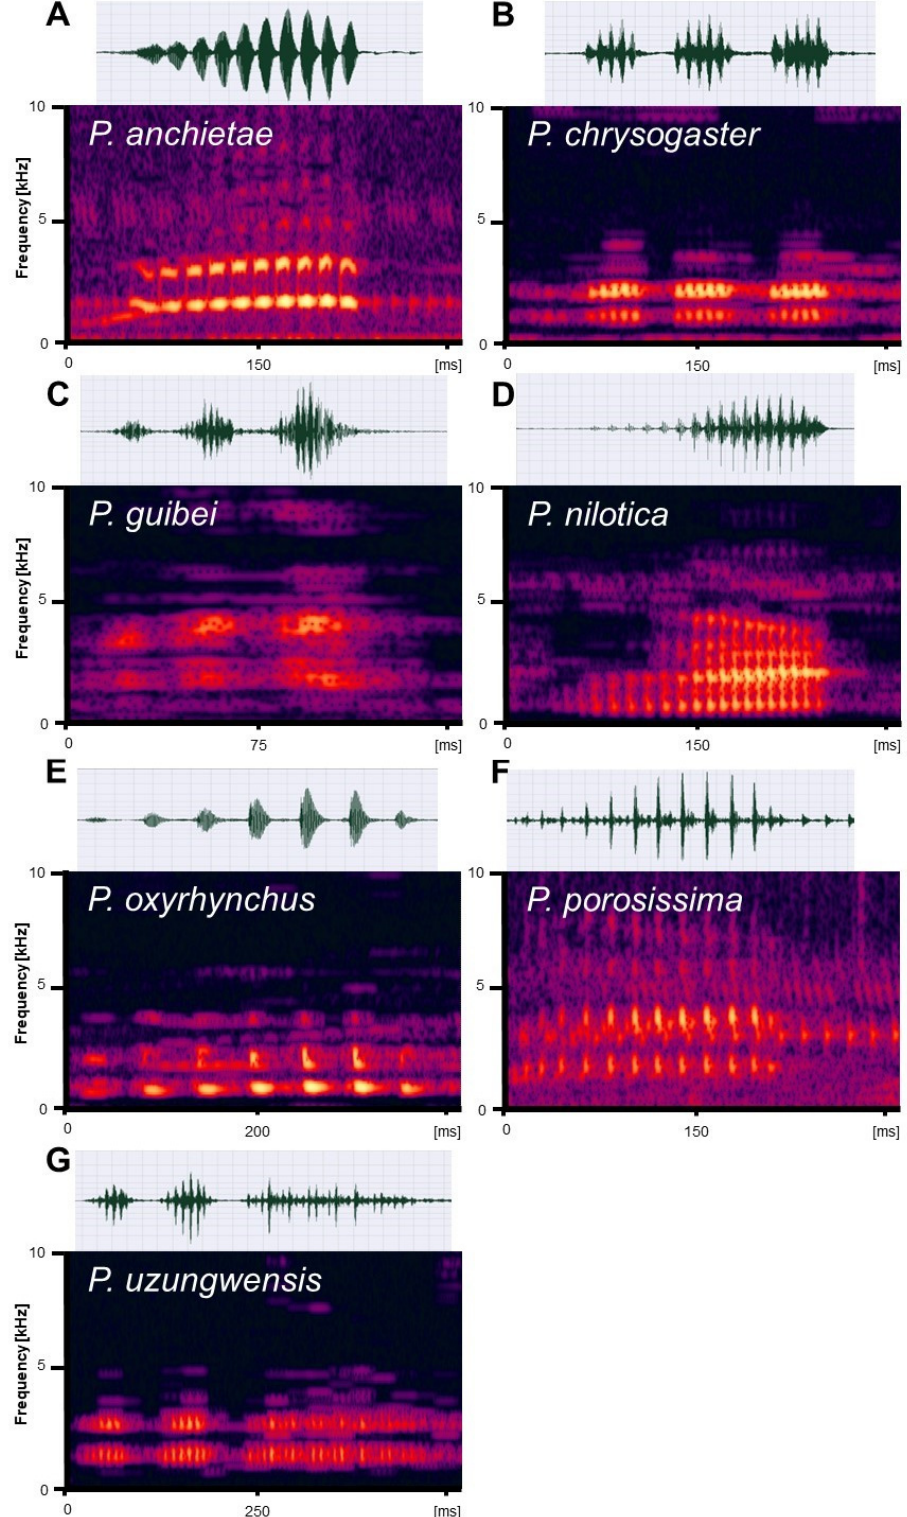
Figure 15. Advertisement calls of Ptychadenidae in Rwanda. ( A ) Ptychadena anchietae , ( B ) Ptychadena chrysogaster , ( C ) Ptychadena guibei , ( D ) Ptychadena nilotica , ( E ) Ptychadena oxyrhynchus , ( F ) Ptychadena porosissima , ( G ) Ptychadena uzungwensis . Calls are shown as representative spectrograms and oscillograms.